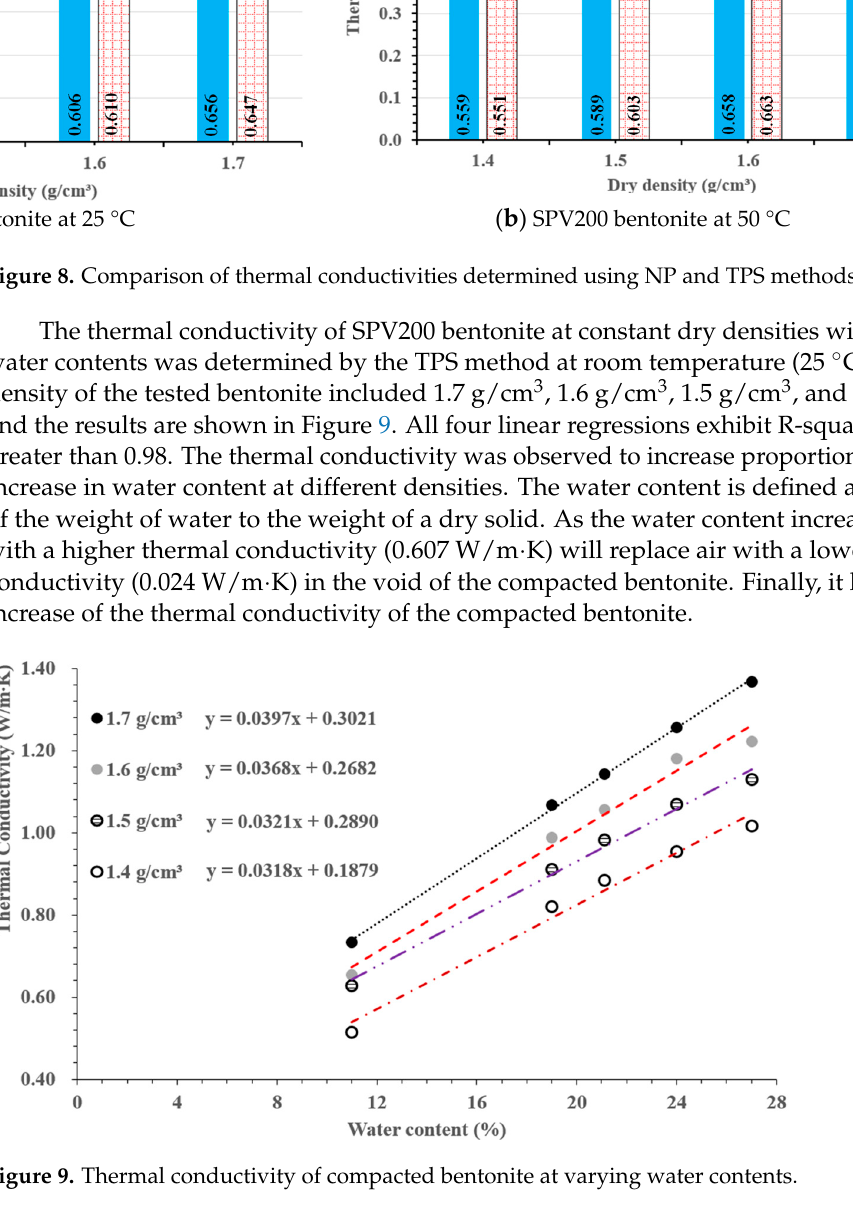
Figure 9. Thermal conductivity of compacted bentonite at varying water contents.